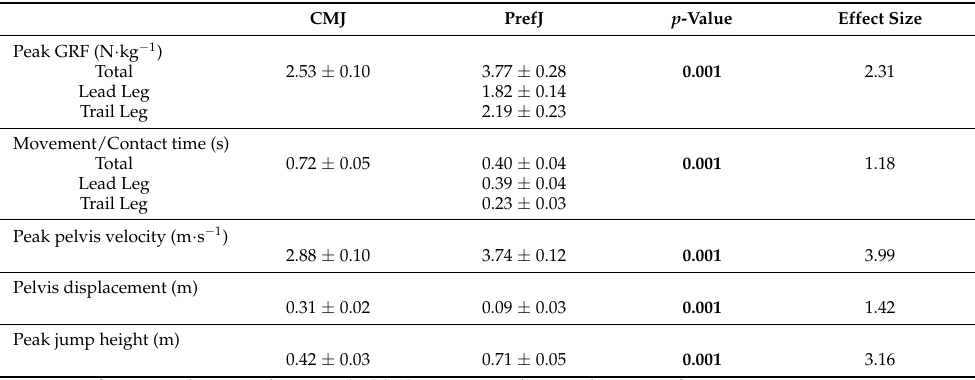
Table 1. Mean ± SD whole-body biomechanical parameters during the countermovement (CMJ) and preferred-style (PrefJ) jumps.